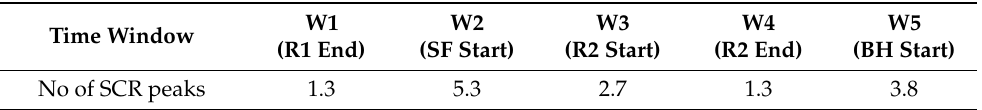
Table 2. Mean number of peaks of the SCR component during the five considered time windows averaged on all the